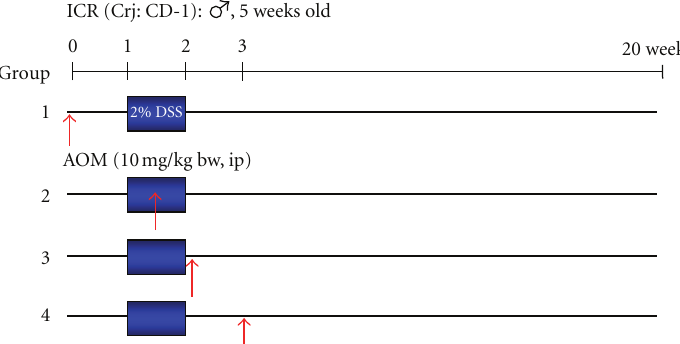
Figure 5: Experimental protocol to develop an inflammation-associated mouse colon carcinogenesis model, to develop a new inflammation- related mouse colon carcinogenesis model [12].